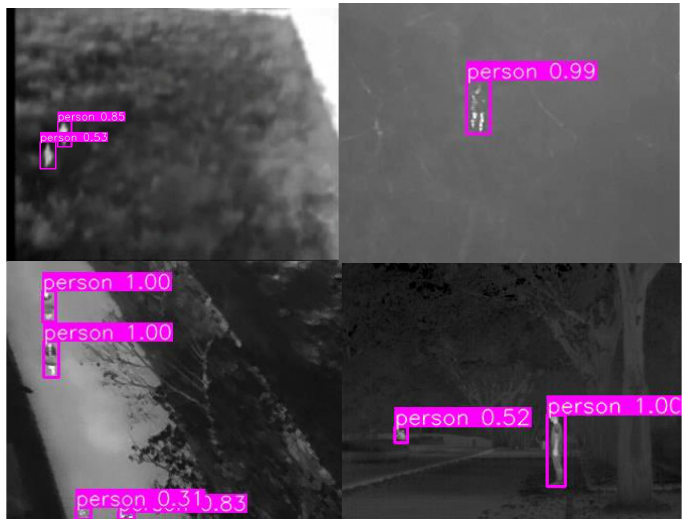
Figure 9. AIR-YOLOv3 test on TX2.The class of the target is